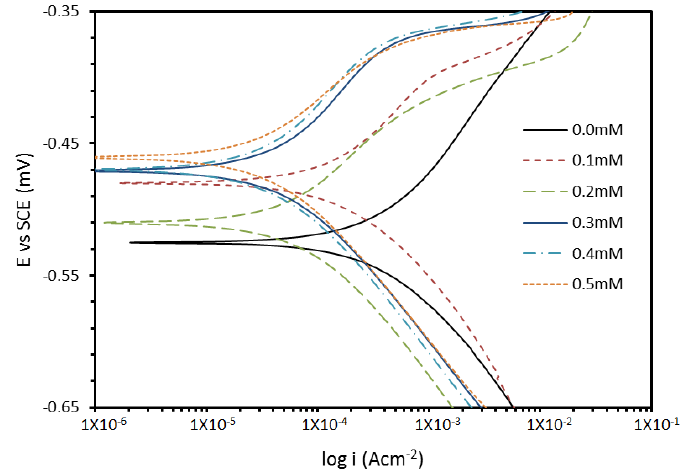
Figure 4. Potentiodynamic polarization curves for mild steel in 1.0 M HCl at 30 °C containing various concentration of